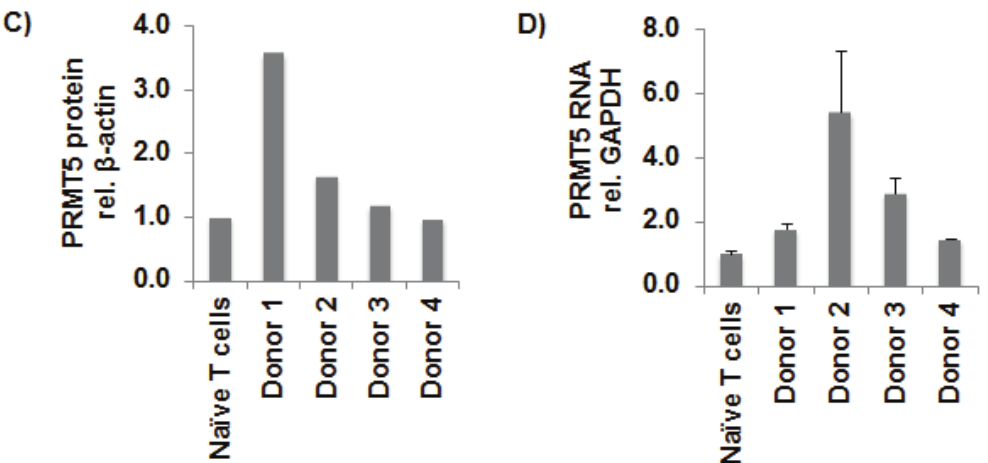
Figure 1. PRMT5 was upregulated in T-cell leukemia/lymphoma cells. ( A ) Total cell lysates of HTLV-1-transformed cell lines (PBL-ACH, ACH.2, SLB-1, Hut-102, MT-1, MT-2, C8166), ATL-derived cell lines (TL-Om1, ATL-43T, ATL-55T, ATL-ED), HTLV-1-negative transformed cell lines (SeAx, Jurkat), and naïve T-cells were subjected to immunoblot analysis to compare the levels of endogenous PRMT5 expression. β -Actin expression was used as a loading control. The amount of PRMT5 in each cell line was measured relative to β -actin; the level of PRMT5 expression obtained with naïve T-cells was set at 1; ( B ) Quantitative RT-PCR for PRMT5 and GAPDH was performed on mRNA isolated from cells in panel A. Total PRMT5 mRNA level was determined using the ∆∆ Ct method [47] and normalized to relative GAPDH levels. Data are presented in histogram form with means and standard deviations from triplicate experiments; ( C ) Lysates of ATLL PBMCs from four independent donors and naïve T-cells were subjected to immunoblot analysis to compare endogenous PRMT5 protein expression levels. β -Actin expression was used as a loading control. The amount of PRMT5 in each condition was measured relative to β -actin and depicted in histogram form; the level of expression obtained with naïve T-cells was set to 1. Each sample was measured in duplicate; ( D ) Quantitative RT-PCR for PRMT5 and GAPDH was performed on mRNA isolated from cells in panel C. Total PRMT5 mRNA level was determined using the ∆∆ Ct method and normalized to relative GAPDH levels. Data are presented in histogram form with means and standard deviations from triplicate experiments.